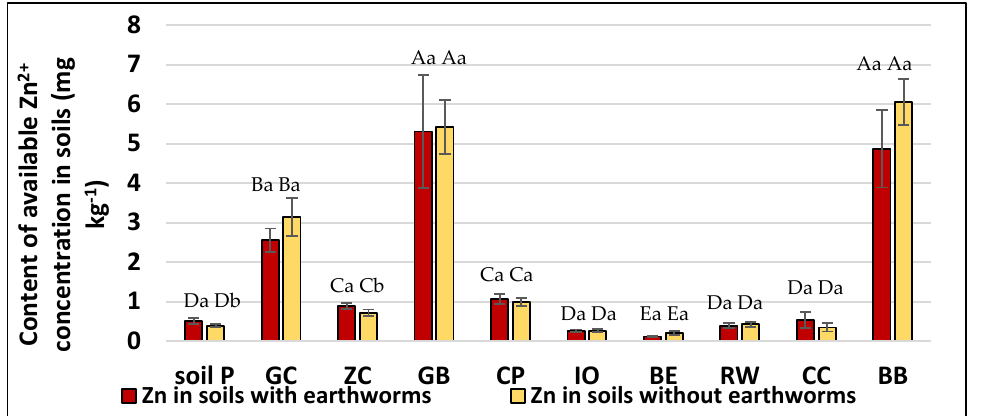
Figure 3. Content of extractable Zn in soils affected by soil amendments and earthworms activity. Different lower case letters within the same type of amendment application indicate significant differences between individual Zn concentration in soils with and without earthworms, while capital letters indicate significant differences between applied amendments (ZC-Zabrze compost, GC-GWDA compost, BB- Bełchatów biosolids, GB -Grabów biosolids, CP-Calcium phosphate, IO- Iron oxide, BE-Bentonite, RW-Rock waste, CC-Limestone; ANOVA, Mann-Whitney test, p < 0.05).